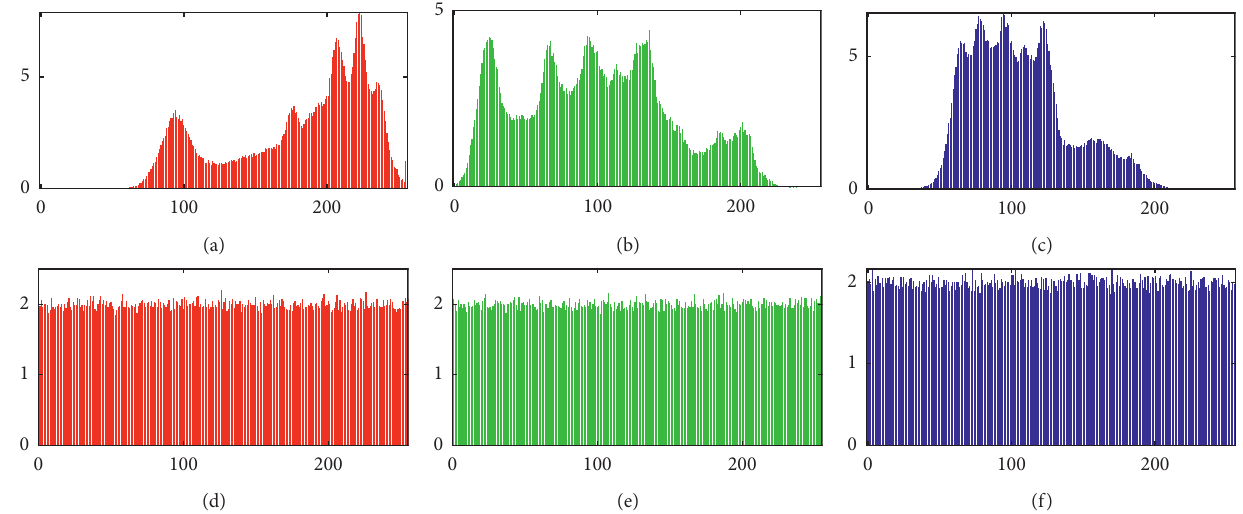
Figure 15: Histograms analysis. (a–c) Histograms of the original image in the RGB channels, respectively; (d–f) histograms of the encrypted image in RGB channels,